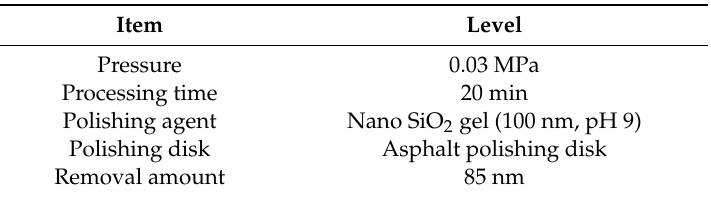
Table 6. CMP parameters